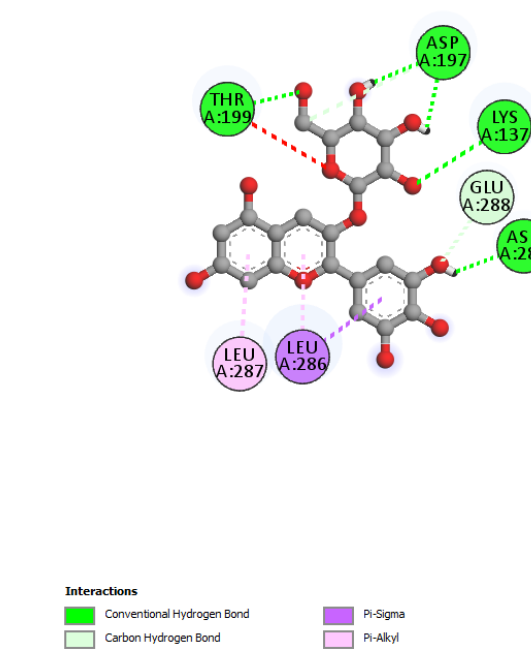
Molecules 2022 , 27 , x FOR PEER REVIEW Figure 6 . Interaction of incanumine ( left ) and solaradixine ( right ) with Mpro ( with bound inhibitor Figure 6. Interaction of incanumine ( left ) and solaradixine ( right ) with Mpro (with bound inhibitor N3). N3 ).